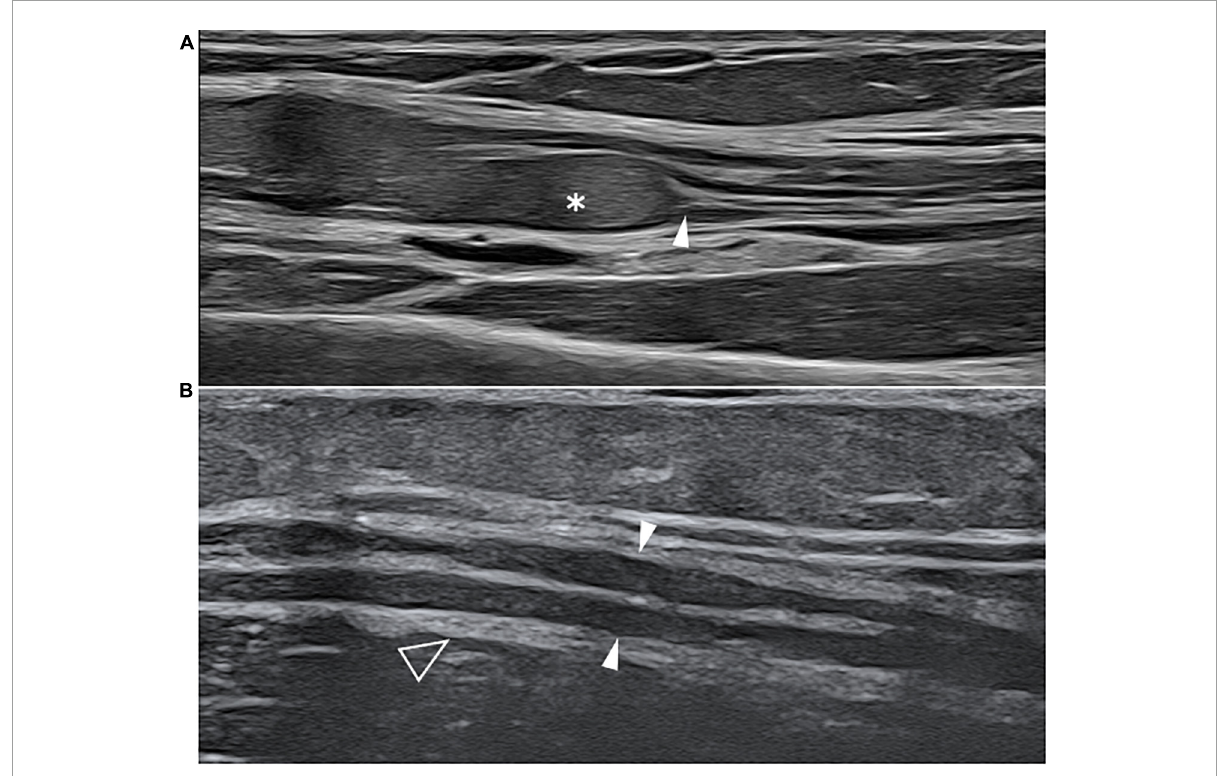
FIGURE4 This figure shows two 22 MHz HRUS images, longitudinal view, one from a 45 years old female patient affected by systemic lupus erythematosus (SLE) who developed a chronic demyelinating polyneuropathy (A) and one from a 53 years old female patient affected by polyarteritis nodosa with a mononeuritis multiplex. The comparison of the two HRUS images point out the main distinguishing features of the two neuropathies: in (A) , there is a marked, iso-hyperechoic, irregular median nerve enlargement (white asterisk) with an abrupt change in caliber (white arrowhead) at the passage between the pathological and unaffected fascicles while in (B) , the ulnar nerve (white arrowheads) presents a slight, diffuse, irregular and hypoechogenic enlargement of the fascicle with a tick epineurium (empty arrowhead). Panel (A) was obtained at the mid-portion of the forearm while panel (B) was obtained at the distal third of the